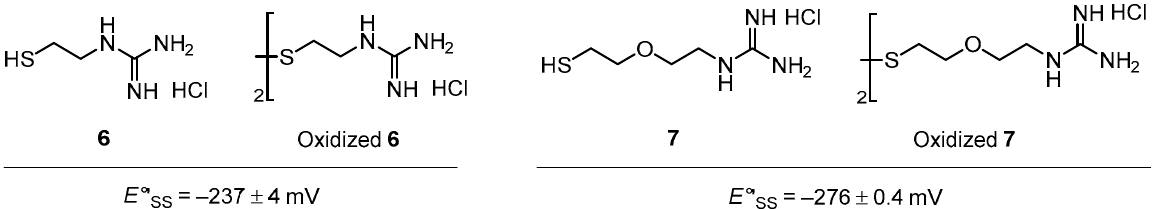
Figure 4. Monothiol compounds 6 and 7 and their oxidized forms with a guanidyl unit.